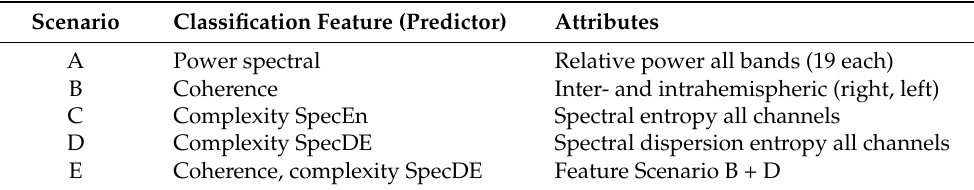
Table 11. Classification test